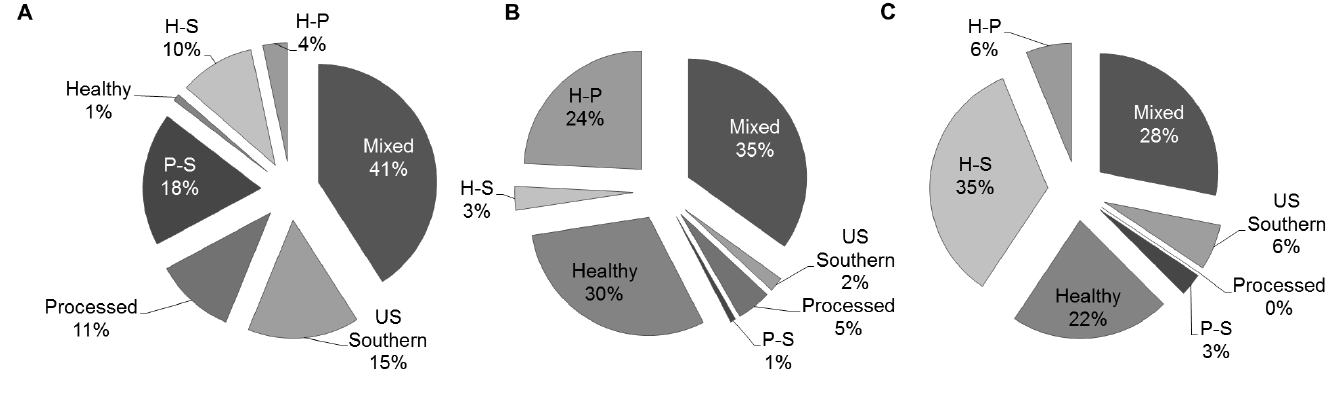
Figure 1. Distribution of dietary patterns during pregnancy in the Conditions Affecting Neurocognitive Development and Learning in Early Childhood (CANDLE) Cohort by race. ( a ) African American; ( b ) Caucasian; ( c )